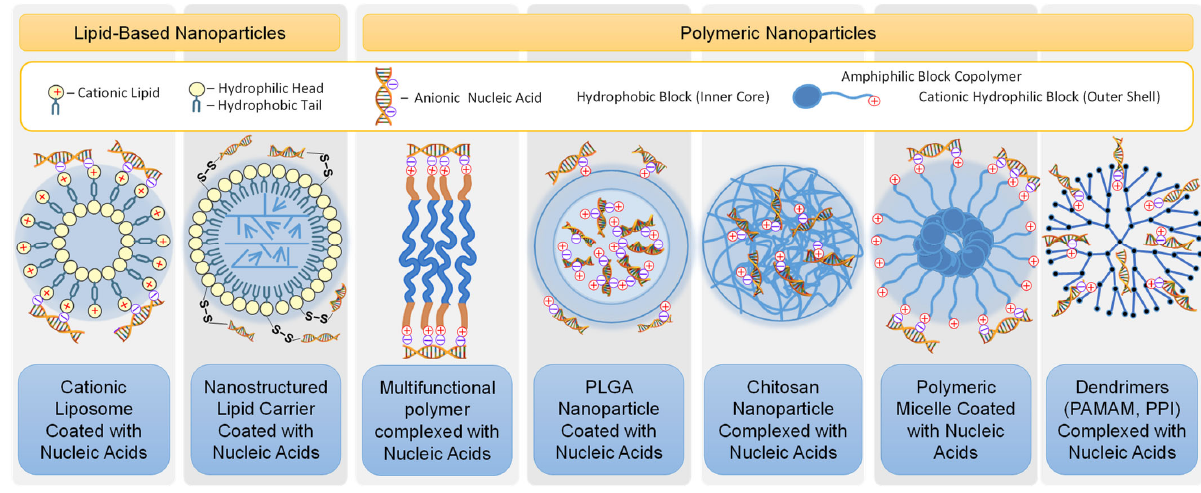
Figure 9. Main types of nanoparticles that can potentially be used for nucleic acid delivery. In terms of overall nanoparticle electric charge or surface charge (so-called Zeta potential), neutral or slightly negatively changed (anionic) vehicles are used due to the fact that positively charged (cationic) liposomes, as well as other cationic nanoparticles, exhibit significant cyto- and genotoxicity to human cells [72,76]. However, the delivery of nucleic acids using weakly negatively charged or neutral particles, although possible, is difficult. It is known that under physiological conditions, nucleic acids have a negative charge [24]. Therefore, it is natural to use a positively charged particle for their delivery. At the same time, it is possible to choose the ratio between negatively charged nucleic acids and cationic vehicles that they would be connected together tightly enough by electrostatic interaction and the resulting complex as a whole would be a neutral nontoxic nanoparticle [72]. In this case, a positive charge can be distributed both on the surface or/and inside the particle (Figure 9). A more complex design of the carrier particle is also possible and will be discussed below. It should be mentioned that the electrostatic interaction between a negatively charged nucleic acid and a positively charged particle is quite strong. On the one hand, the formation of a firm complex is helpful because it protects the resulting composite from decay, while moving inside the body, thereby protecting relatively unstable nucleic acids from degradation. However, on the other hand, such a strong interaction presents certain difficulties for the separation of nucleic acids from particles inside the cell, preferably into the cell cytoplasm so that nucleic acids can play its targeted role in cellular processes. In most cases, the internalization of relatively large nanoparticles by the cell occurs by endocytosis (Figure 10). Having entered the cell by endocytosis, the nanoparticle finds itself inside the endosome, which represent a membrane vesicle budded from the cellular plasma membrane. There are four main mechanisms by which RNA bound to nanoparticles can escape the endosome into the cell cytoplasm. In order to facilitate one or several of such mechanisms, different modification of nanoparticles and/or an entire complex have been proposed [87]. Without going into details, we only note that the use of these intracellular mechanisms, the release of RNA from its complex with a nanoparticle, makes it possible to prevent nucleic acids from being destroyed and allows RNA release into the cellular cytoplasm, where its intracellular action